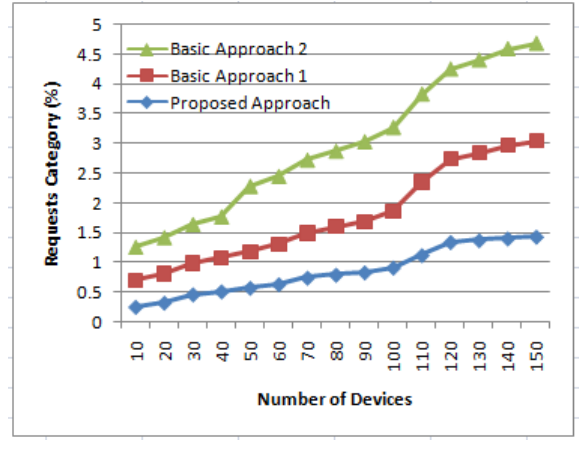
Figure 8. Request Category.